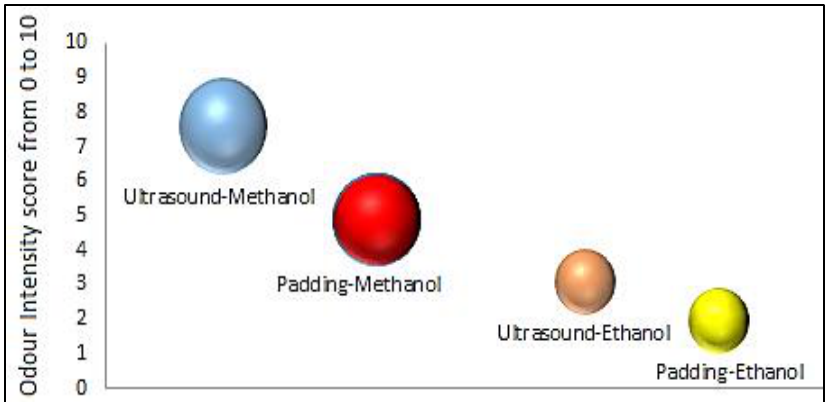
Figure 1. Effect of methanol and ethanol on the odor intensity for ultrasound and padding methods for PET and CO.